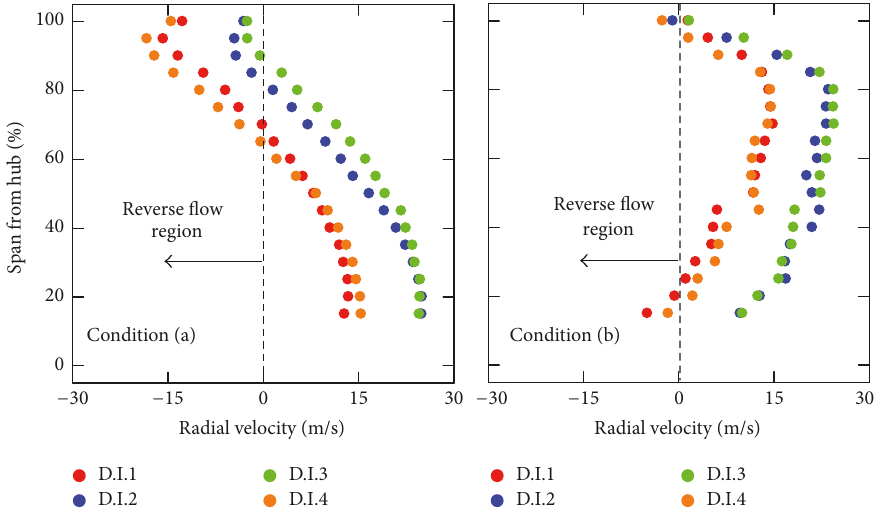
Figure 15: Spanwise radial velocity distributions of the impeller-discharge flow on conditions (a) and